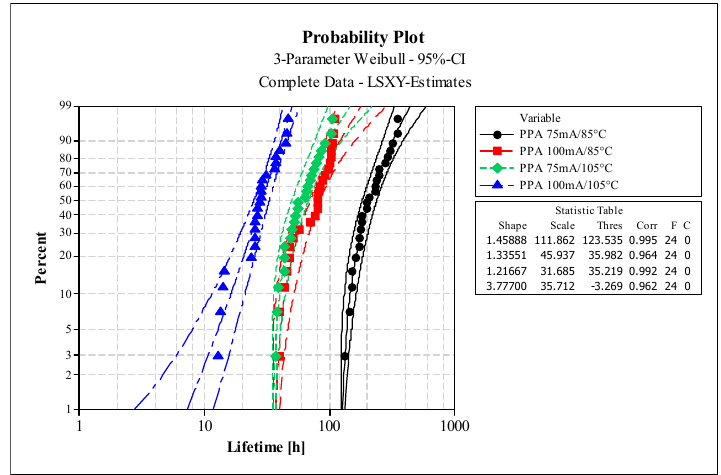
Figure 20. Probability plot on the basis of 3-Parameter Weibull distribution, including 95% lower and upper confidence intervals.